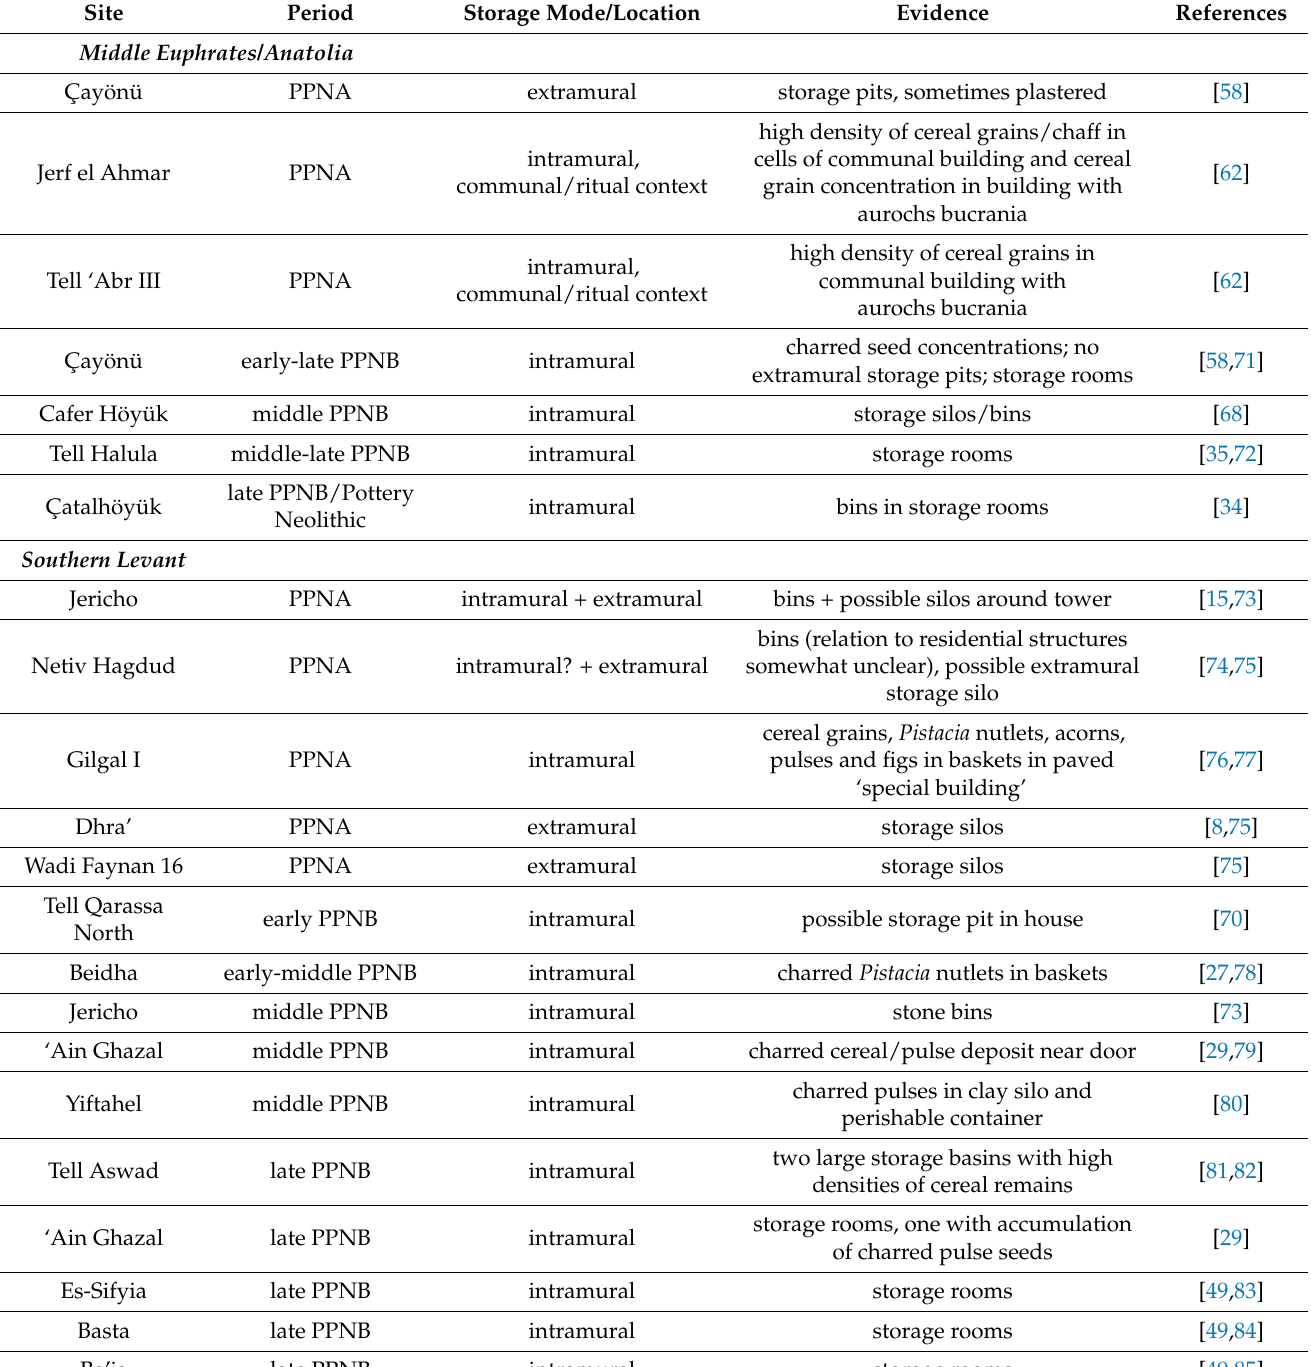
Table 2. List of possible PPN storage structures and contexts at selected